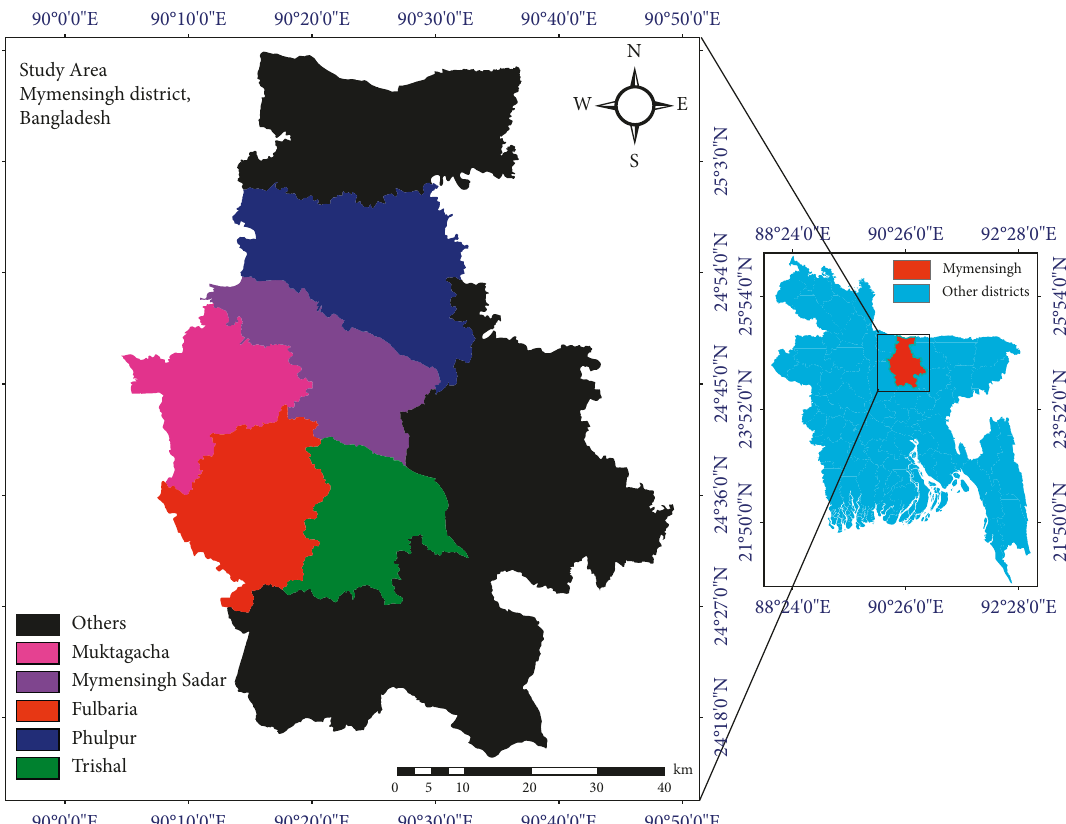
Figure 1: Sampling area map of the selected Upazilas of Mymensingh district, Bangladesh. Images were extracted from DIVA-GIS (https:// www.diva-gis.org/) and provided by the Geographical Information System (GIS). Finally, the map was created using ArcMap software 10.7 (ArcGIS Enterprise, ESRI, Redlands, California,